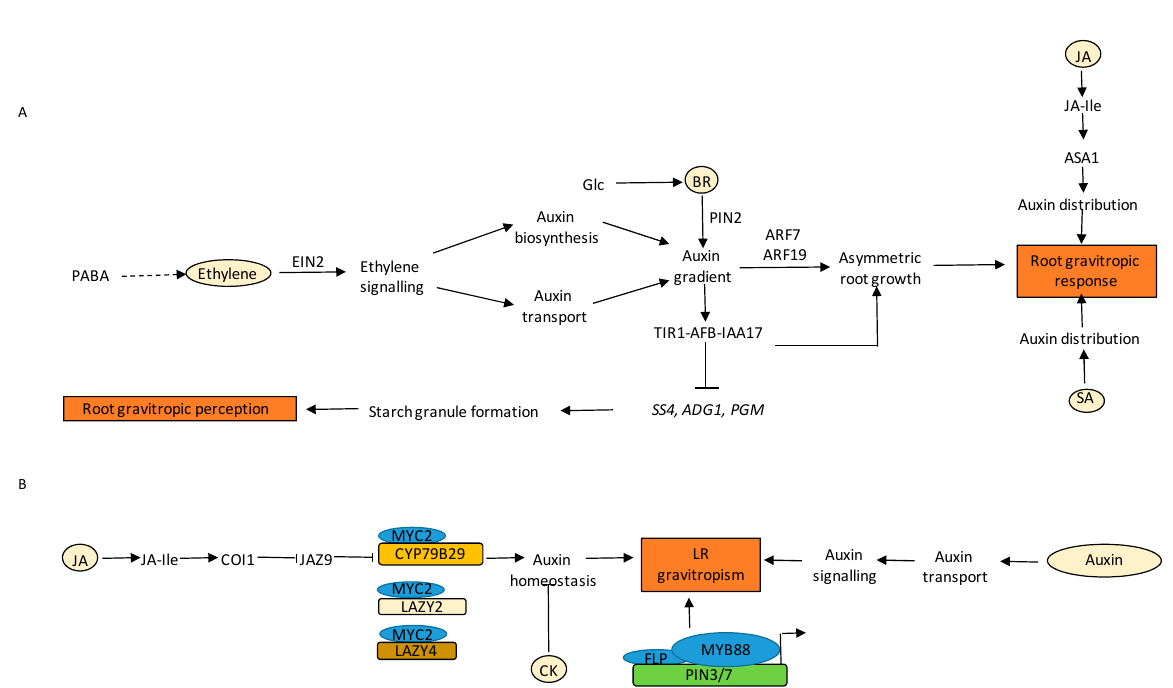
Figure 6. Regulation of PR and LR gravitropism by various hormones and their crosstalk. ( A ) PABA works upstream of ET signalling, through which it regulates auxin biosynthesis and transport. This ultimately leads to ARF7/19 mediated auxin activity effects on asymmetric growth promotion followed by root gravitropic response. Glc acts via BR to regulate root gravitropism. BR regulates root gravitropism by interacting with auxin via PIN2 distribution. Auxin signalling module TIR1-AFB-IAA17 mediates starch granule formation and gravitropic perception by inhibiting the expression of PGM , ADG1 , and SS4 . JA influences gravitropic response by modulating auxin levels through SA1 induction. SA affects auxin transport and redistribution, leading to gravitropic bending. ( B ) The presence of JA activates COI1-mediated JA signalling that causes proteasomal degradation of JAZ9, leading to the liberation of MYC2, which then binds to the promotors of CYP79B2 and LAZ2 and LAZY4 , leading to changes in auxin homeostasis and LR gravitropism. Auxin transport and signalling modules are essential to regulate vertical orientation of LRs. The binding of FLP and MYB88 TFs leads to transcriptional activation of PIN3 and PIN7, which then lead to gravitropic bending of LRs. CK perturbs auxin homeostasis, leading to horizontal branching of LRs. Solid black arrows indicate confirmed